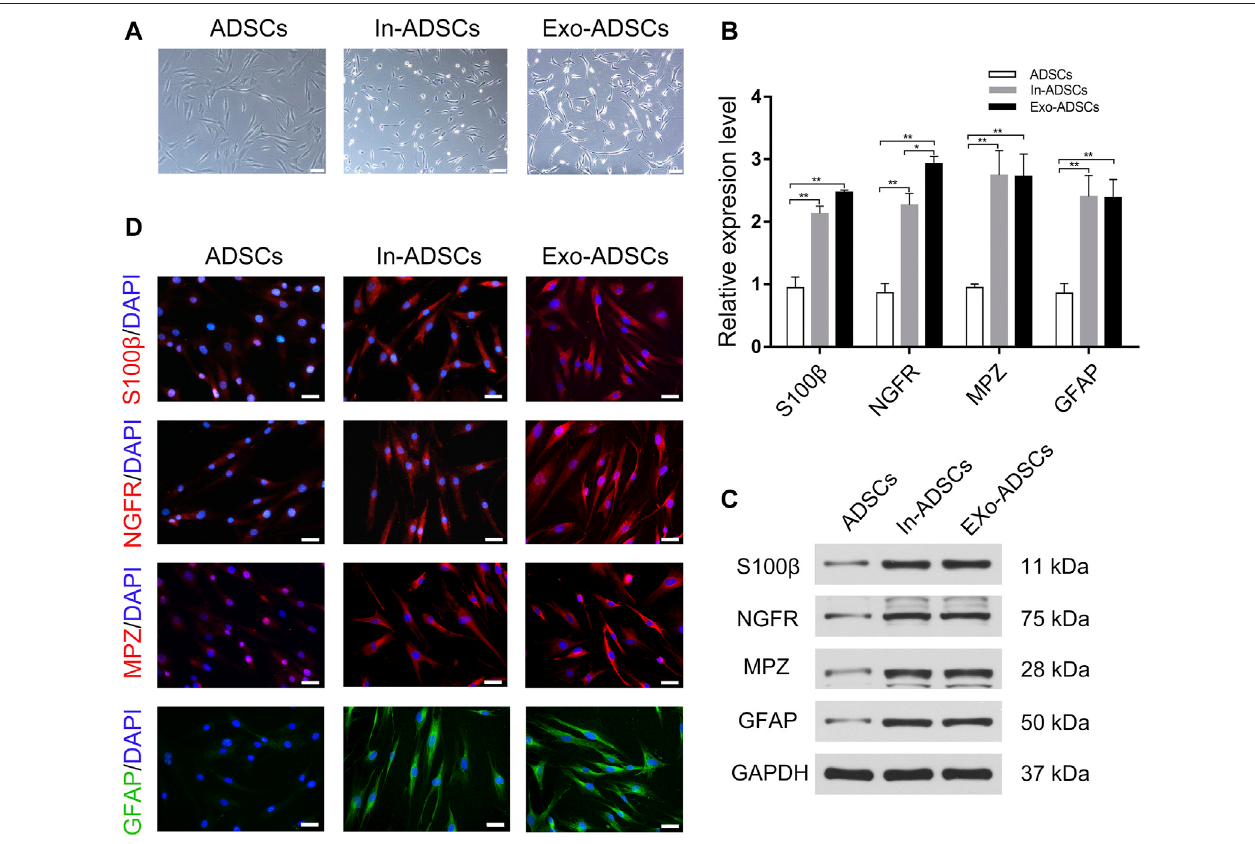
FIGURE 3 | Phenotypic characteristics of In-ADSCs and Exo-ADSCs. (A) Images of ADSCs, In-ADSCs, and Exo-ADSCs taken under a phase-contrast microscope.Scalebar:100 µm. (B) RT-qPCRanalysisshowingthemRNAlevelsofS100ß,NGFR, MPZandGFAPinADSCs,In-ADSCs,andExo-ADSCs. (C) Western blot analysis showing the protein levels of S100ß, NGFR, MPZ and GFAP in ADSCs, In-ADSCs, and Exo-ADSCs. (D) Fluorescence microscopy showing the immunoreactivity of S100ß, NGFR, MPZ and GFAP in ADSCs, In-ADSCs, and Exo-ADSCs. Scale bar: 50 µm. The data was presented as the mean ± SD ( n (cid:1) 3 independent experiments). * p < 0.05, ** p <